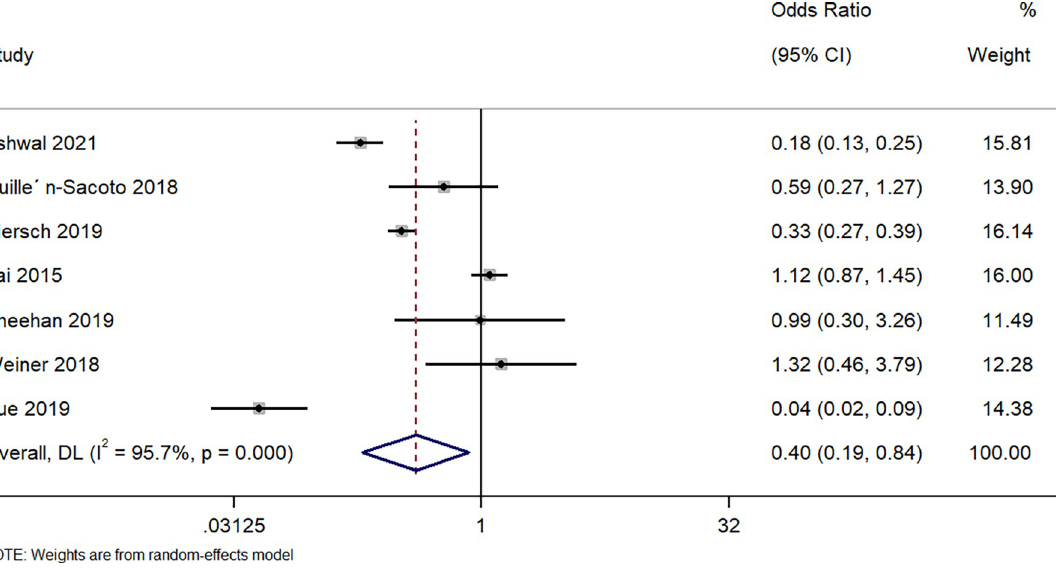
Fig 5. Forest plot showing the difference in small for gestational age neonates between women with a singleton pregnancy or twin pregnancy and GDM. NOTE: Weights are from random-effects model.